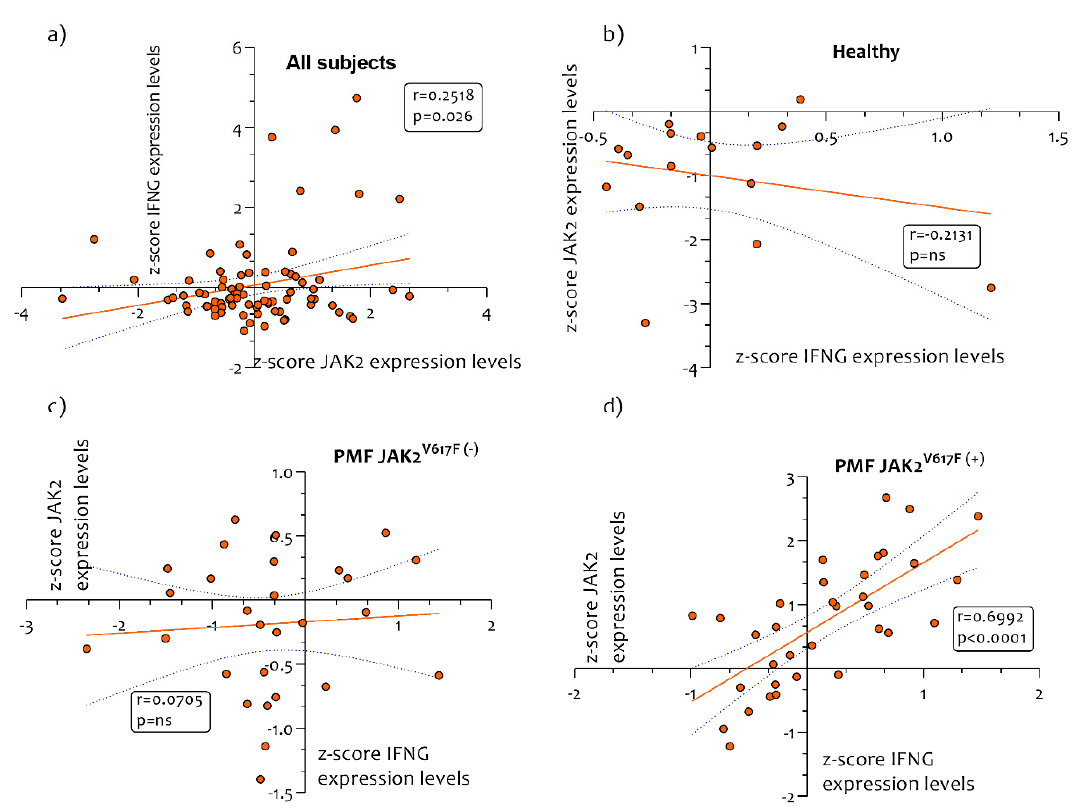
Figure 5. Correlation analysis between IFNG / JAK2 expression levels. A Pearson correlation analysis was performed in order to verify the potential correlation between JAK2 and IFNG in healthy controls subjects and in PMF patients. We showed a positive correlation (r = 0.2518, p = 0.026) in all the subjects recruited in the study between IFNG / JAK2 expression levels ( a ). No correlation was observed in healthy controls subjects ( b ) and in PMF patient’s wild-type for JAK2 V617F mutation (B / C). A significantly positive correlation was observed in PMF patients mutated for JAK2 V617F (r = 0.6992, p < 0.0001) ( c ). p values <0.05 were considered to be statistically significant.